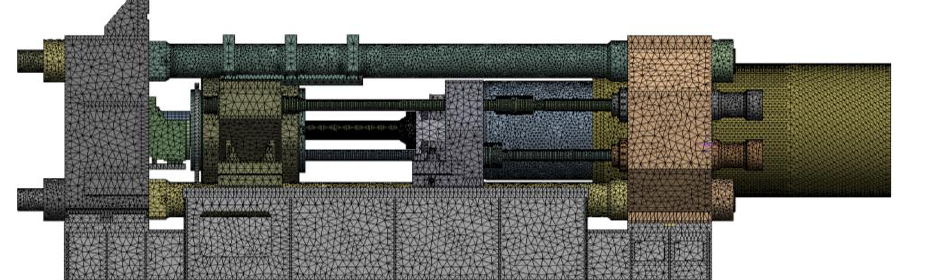
Figure 2. Finite element modeling of the extruder. Table 1. Material properties.